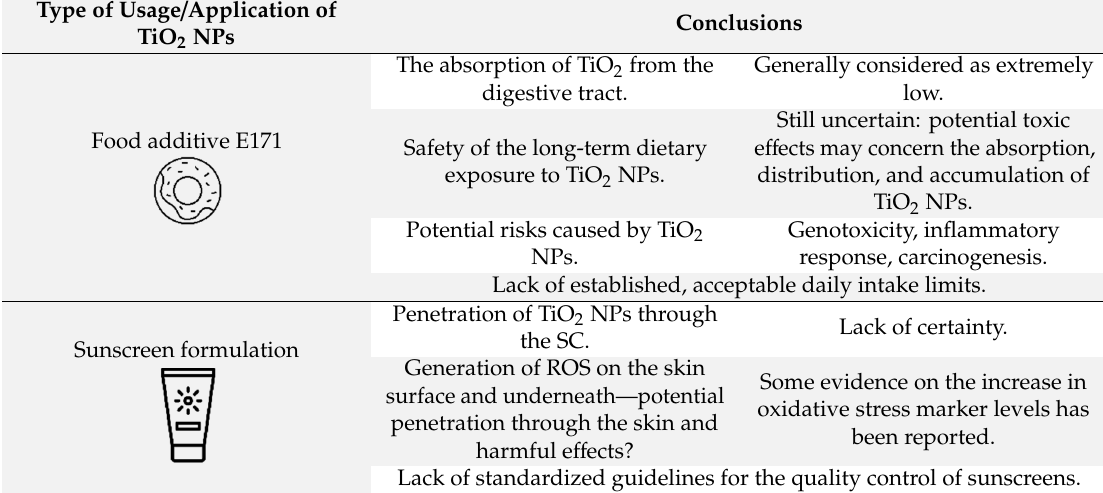
Table 2. Conclusions on the review of the literature regarding the safety of titanium(IV) oxide nanoparticles.